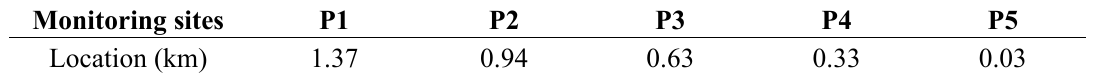
Table 1. Monitoring sites along the Hongqi